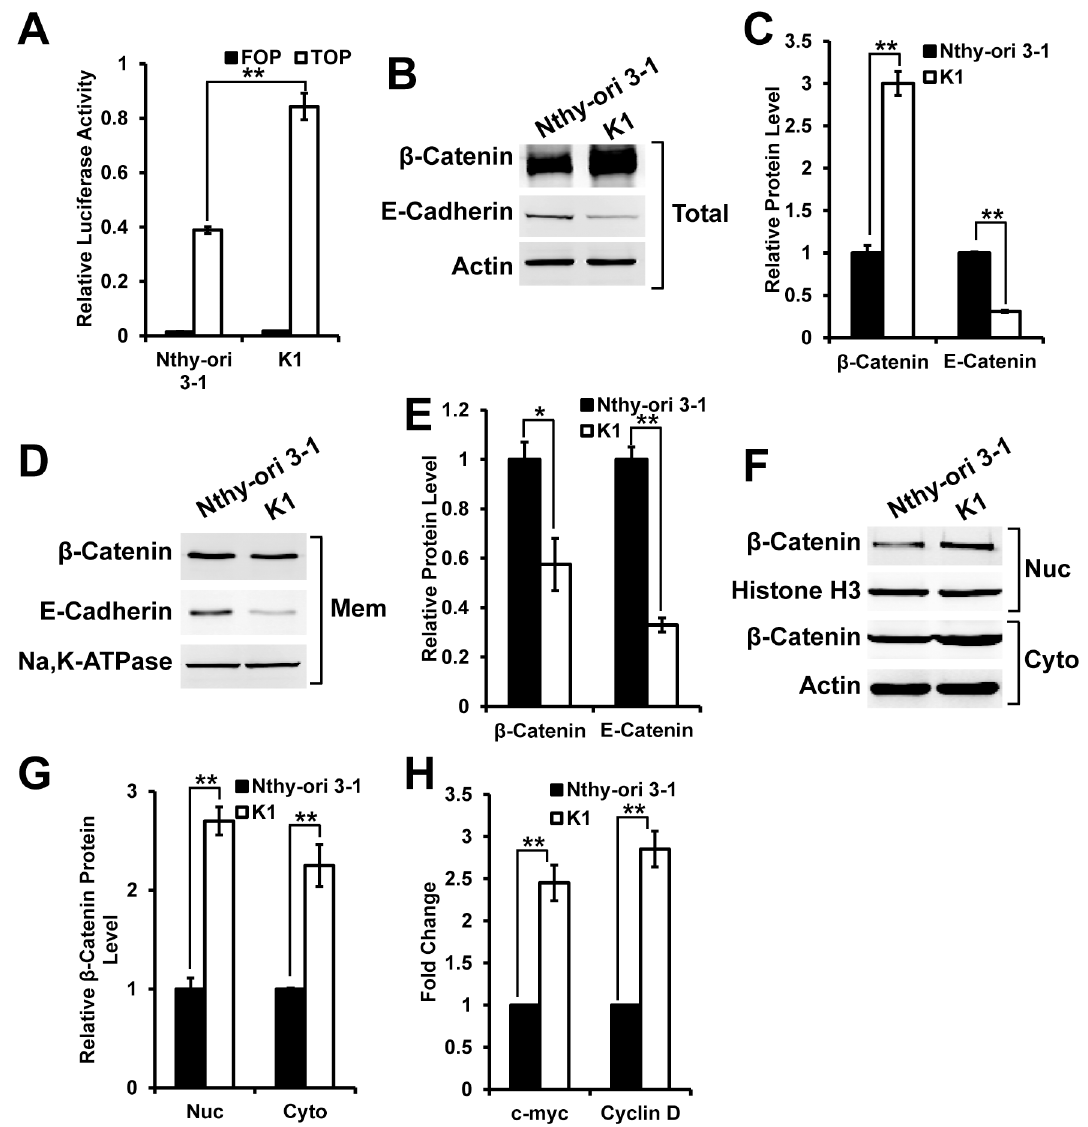
Fig 1. K1 cells have enhanced Wnt signaling. (A) Wnt signalingactivity reporter TOP-Flash reporter showedK1 cells have higherWnt signaling activity than normal thyroid Nthy-ori 3–1 cells. FOP-Flash served as a control; (B) Immuno blot showedincreased β -catenin level and decreased E-cadherinlevel in wholecell extraction from K1 cells. Actin serves as a loadingcontrol; (C) Quantification of band intensity in (B); (D) Immuno blot showeddecreased β -catenin level and E-cadherin level in membraneextraction from K1 cells. Na,K-ATPase serves as a loadingcontrol; (E) Quantification of band intensity in (D) (F) Immuno blot showedincreased β -catenin level in both nuclearand cytoplasmic extraction from K1 cells. Actin and Histone H3 serves as loadingcontrols; (G) Quantificationof band intensity in (F); (H) mRNA expressionof c-Myc and Cyclin D1 relative to the level of GAPDH in Nthy-ori 3–1 and K1 cells. The data were collectedfrom at least three independent experiments. ** <